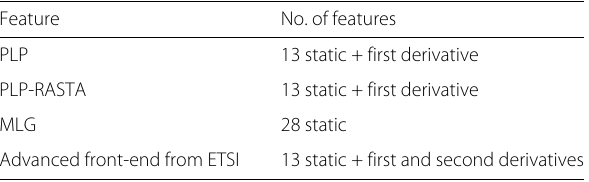
Table 7 Features used in the AUDIMUS decoders Feature No. of features